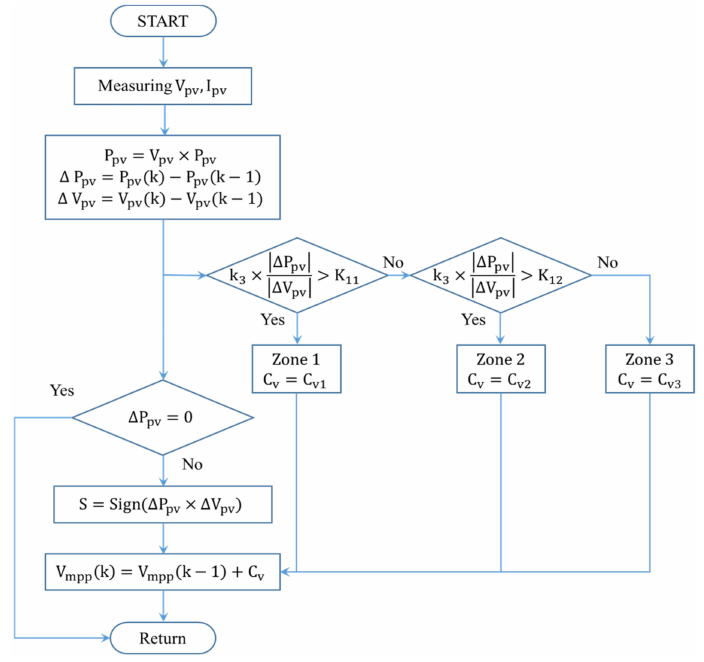
Figure 9. Flowchart of the modified P&O